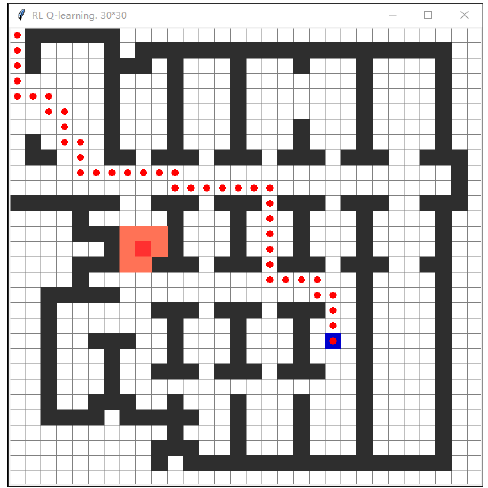
Figure 12. Fire environment path planning.